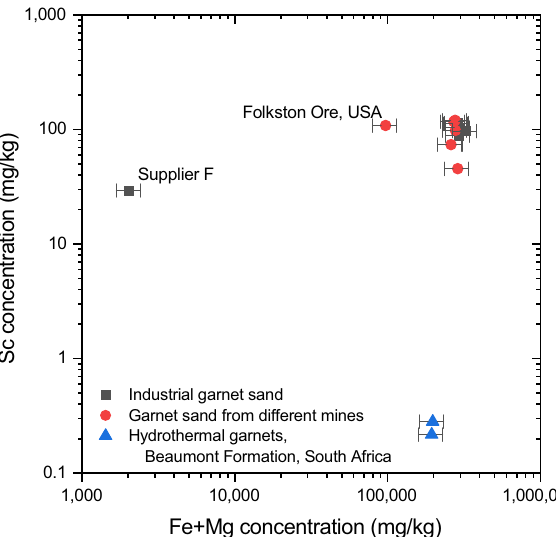
Figure 3. Graph of Fe + Mg concentration vs. Sc concentration (all mg/kg) for all garnet sands and hydrothermal garnets studied. The substantial variation of Sc concentrations at rather similar Fe + Mg concentrations suggests that in addition to the preferential incorporation of Sc as a substitute for Fe 2+ and Mg 2+ in the crystal lattice of garnets (i.e. the garnet type), the initial Sc concentrations in the parent rock also has a strong impact on the Sc concentration in garnet. The Sc error bars are based on 2 times the RSD of the repeated measurement of sample Supplier C b on two different ICP-MS. Note that for most samples the error bar is smaller than the symbol size. The Fe + Mg error bars are based on 2 times the RSD of the repeated measurement of the